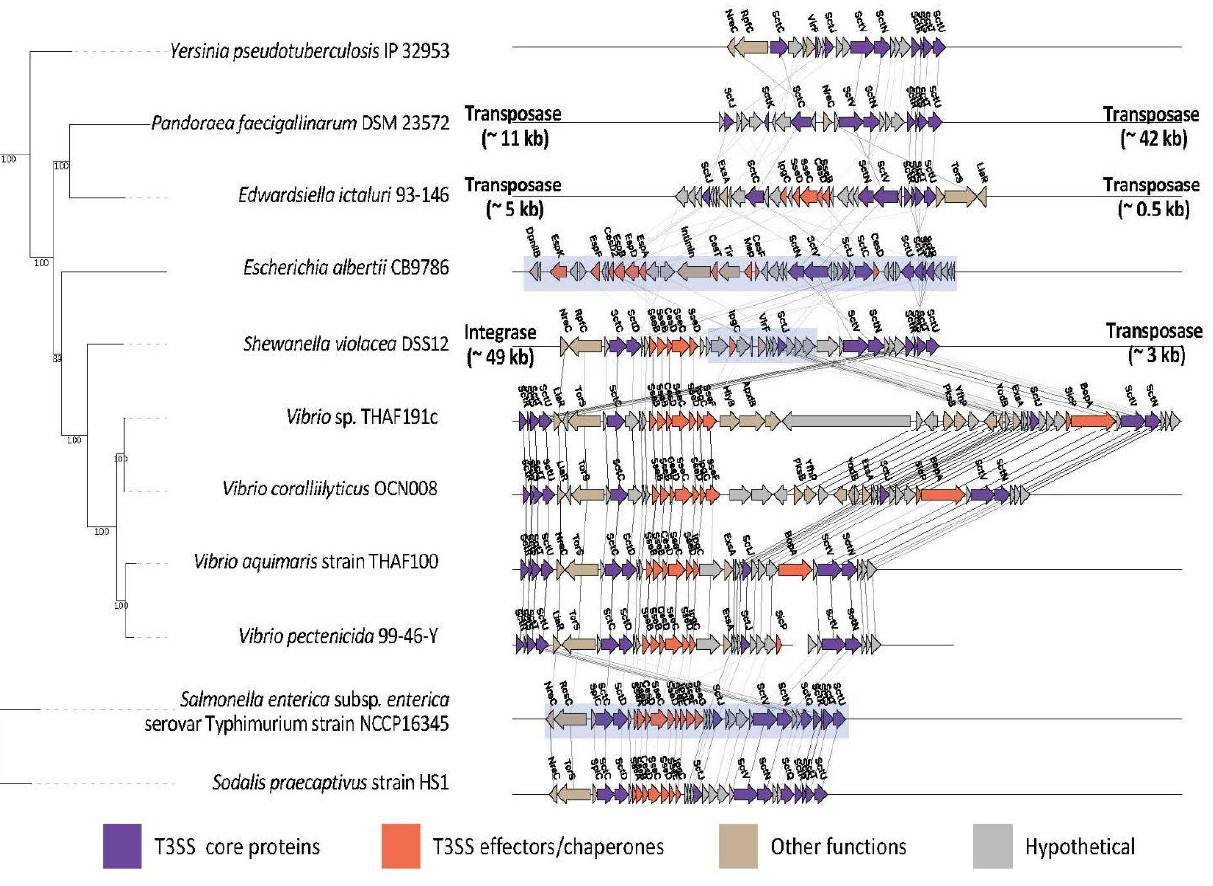
Figure 4. Phylogenetic tree of concatenated SctN-SctS-SctU-SctV proteins and the gene order of the Ssa-Esc family. Graphical notation is the same as Figure 3.